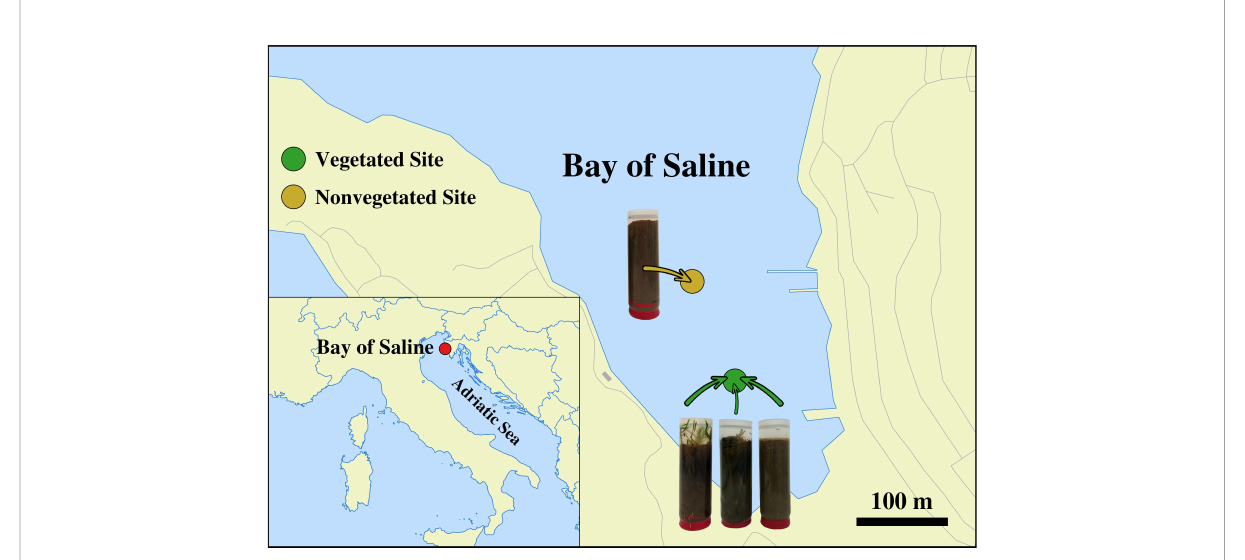
FIGURE 1 Location of the vegetated (declining Cymodocea nodosa meadow) and nonvegetated site in the Bay of Saline, northern Adriatic Sea, together with visual representations of vegetated and nonvegetated sediment cores (© OpenStreetMap contributors,